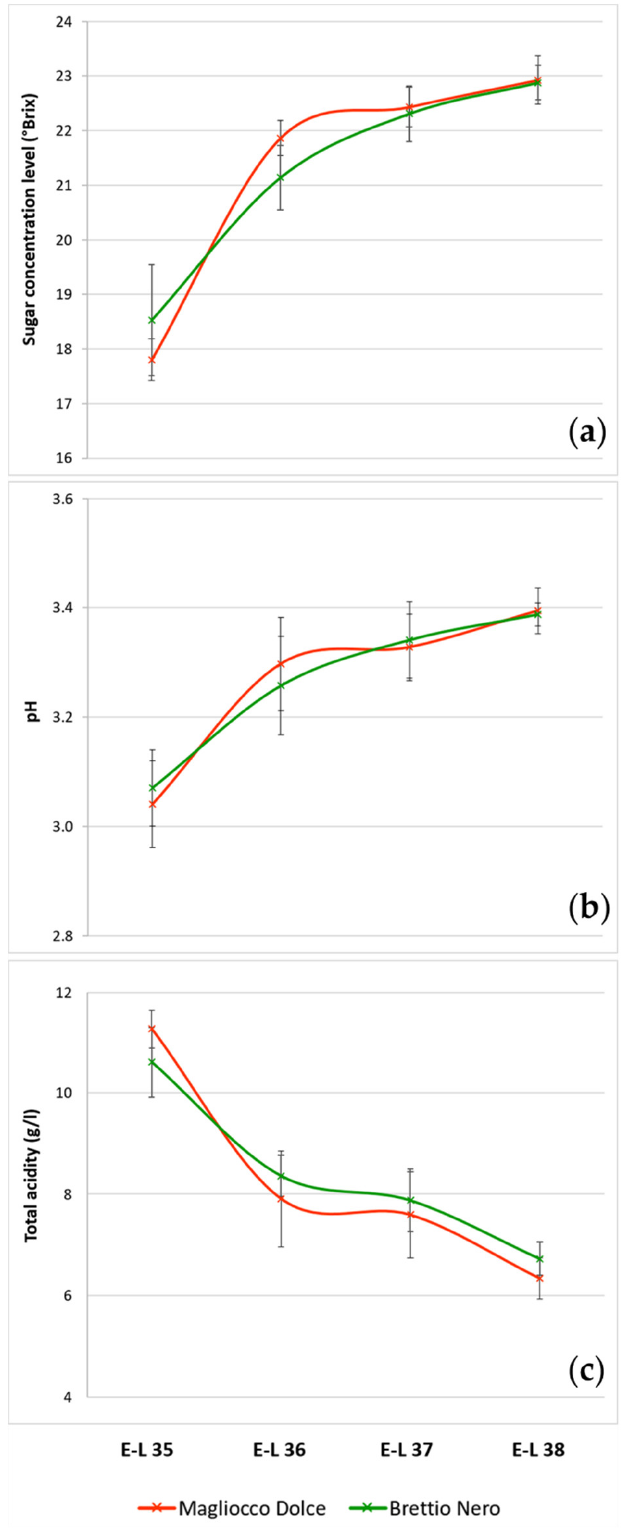
Figure 2. Changes in sugar concentration ( a ), pH ( b ), and total acidity ( c ) during veraison in Mag- liocco Dolce and Brettio Nero varieties. Samples were collected for three seasons (2016–2018) at 4 distinct time points: beginning of veraison (E-L 35), middle veraison (E-L 36), end of veraison (E-L 37), and maturity (E-L 38). Standard unpaired Student’s t -test was used for comparison of two va- rieties.